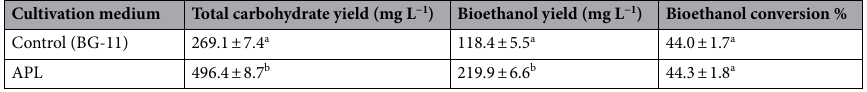
Table 7. Bioethanol production in control (BG-11) and APL medium along with the conversion efficiencies. Values were calculated as the mean (± SE) of three independent observations, i.e., n = 3. Significant differences among the values (P < 0.05, DMRT) within a column are designated using different alphabetic annotations.